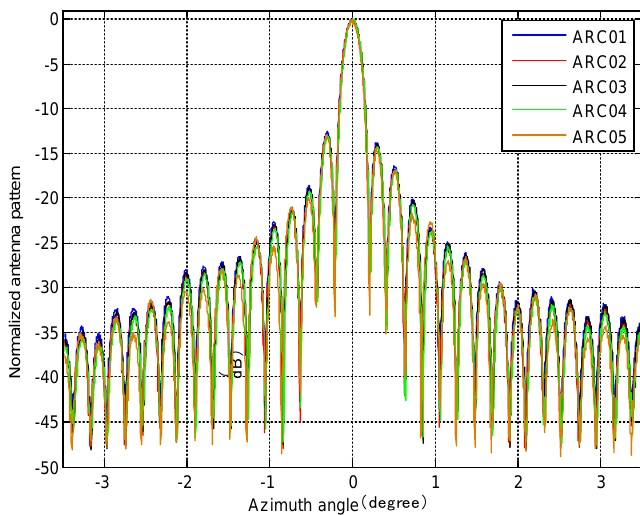
Figure 11. Azimuth pattern measurement for the strip-mode in quad-polarization.